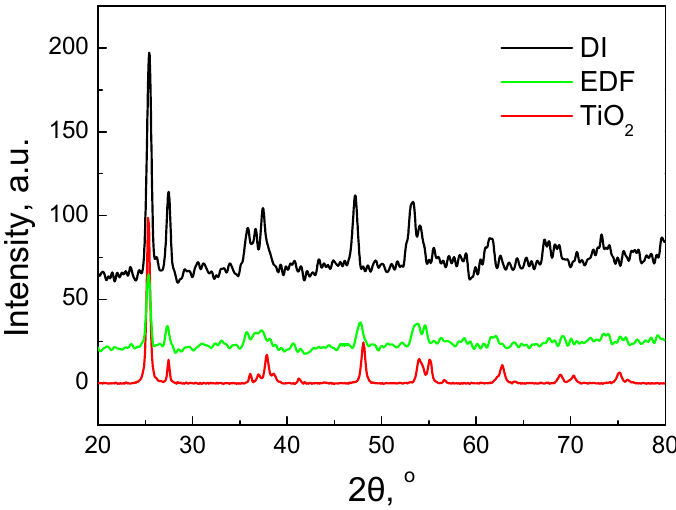
Figure 5. XRD patterns of EDF and DI catalysts and TiO 2 support.